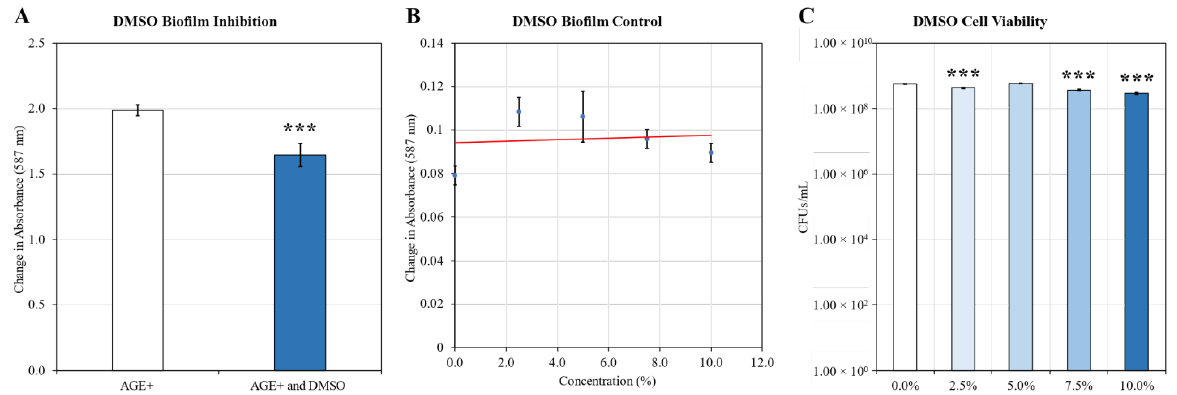
Figure A4. Effects of DMSO on biofilm formation and cell viability. ( A ) Biofilm inhibitory effect of 5.0% DMSO after 48 h of growth under static conditions with 0.5 mg/mL glucose-keratin. n = 8. Mean ± standard deviation. Statistical difference determined by Student’s t-test compared to control.